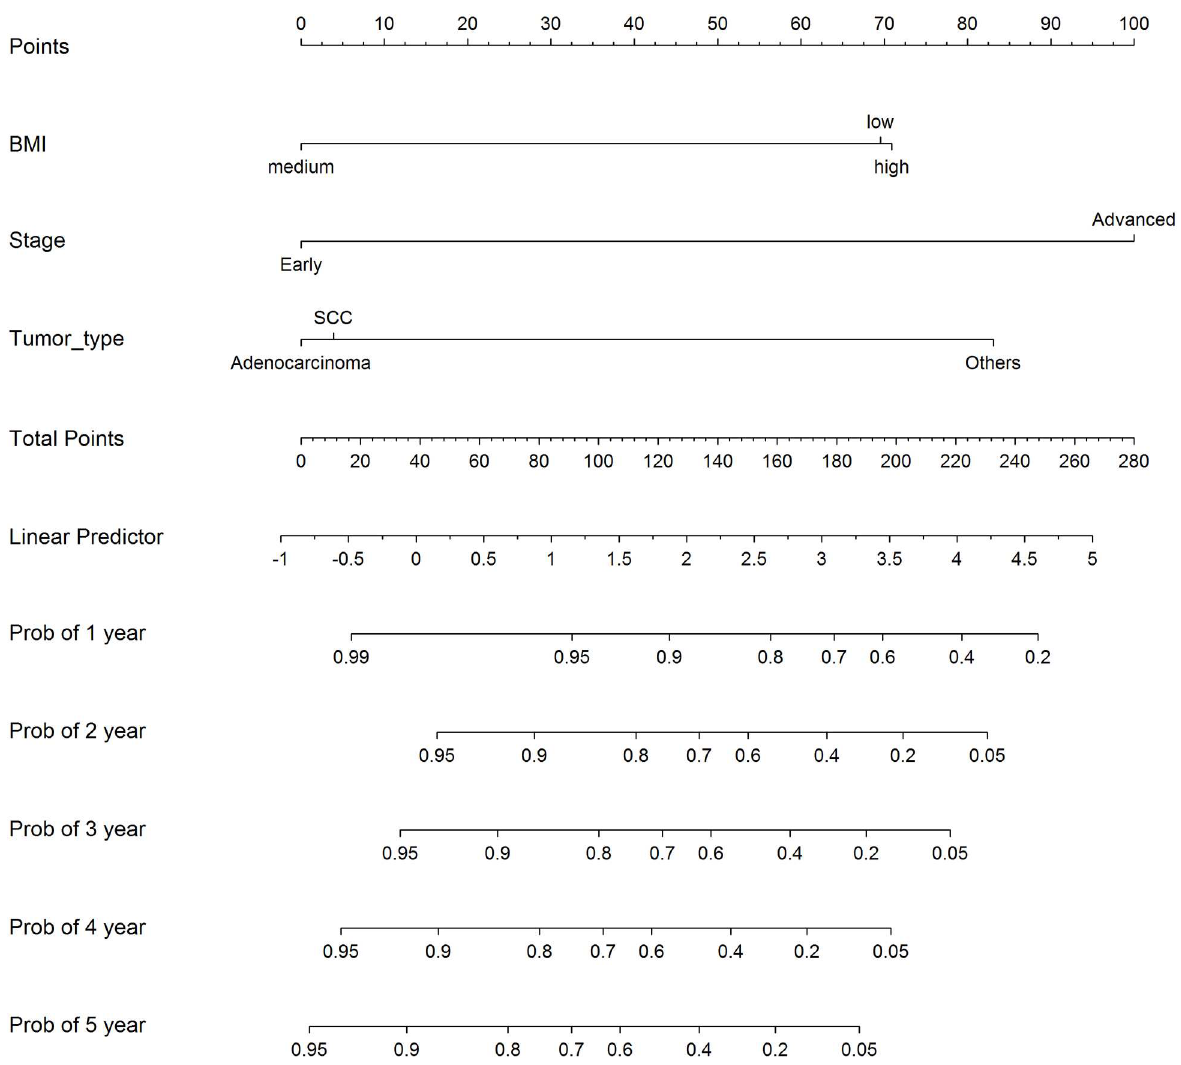
Fig 4. Nomogram of survival probabilities with independent risk factors using the validation cohort of 300 patients. Survival probabilities after 1 year through 5 years are calculatedbasedon the effects of the three risk factors.